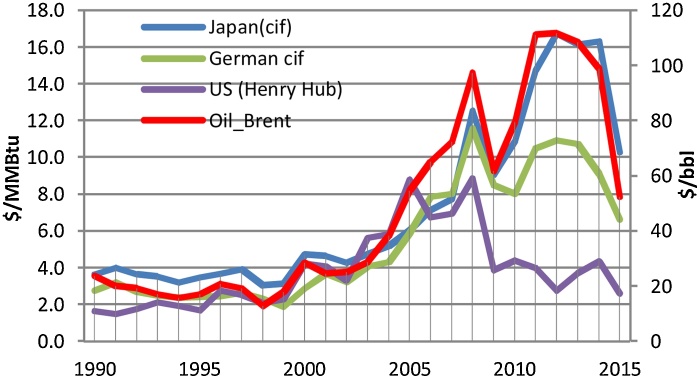
The price of natural gas in the world. Data Source: BP Statistical Review of world energy (2016).